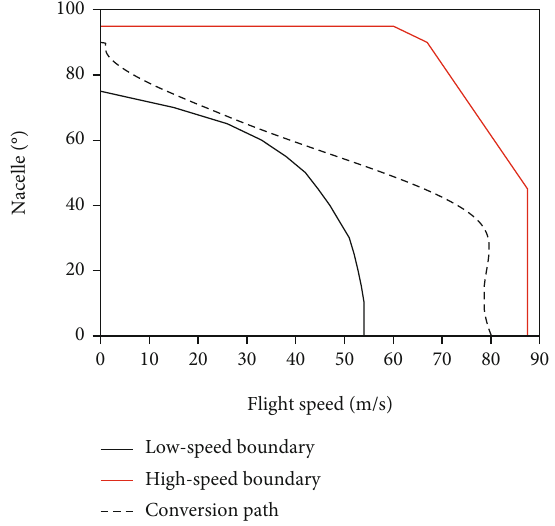
Figure 17: Conversion path